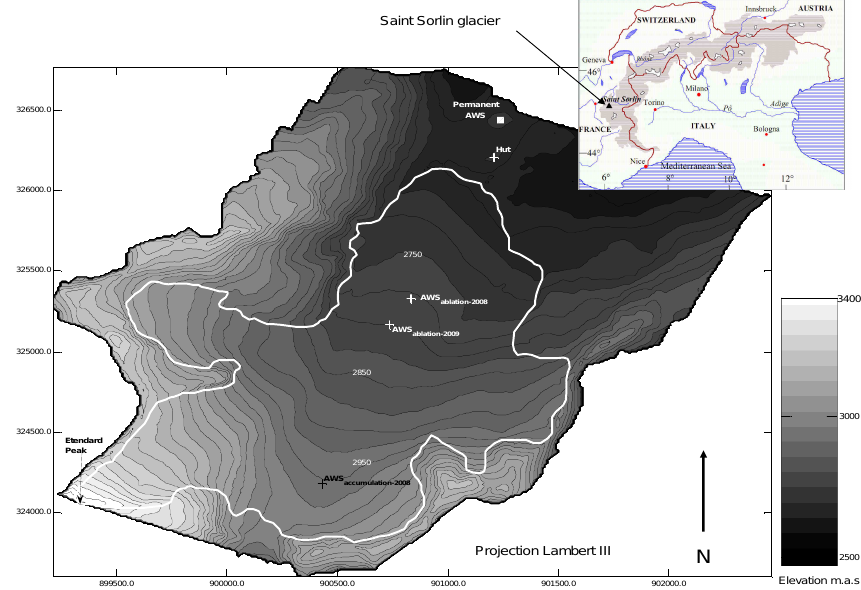
Fig. 2. Map of Saint Sorlin Glacier. Location of the AWS used for validation during summer 2008 and summer 2009 are indicated on the glacier. The cameras take photographs from the hut. Etendard peak is also